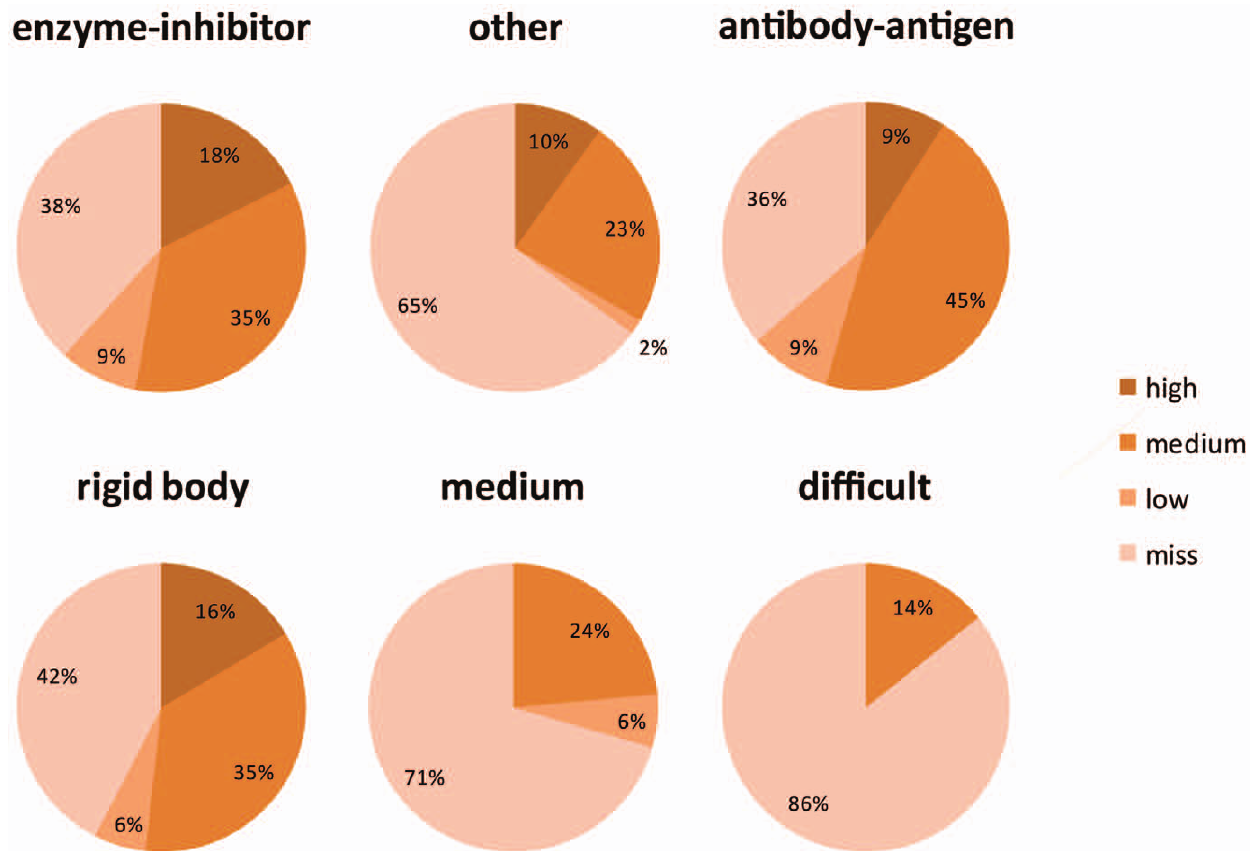
Figure 4. Breakdown of benchmark results. The RosettaDock benchmark performance in terms of docking success and accuracy across both complex type (A) and docking difficulty (B).